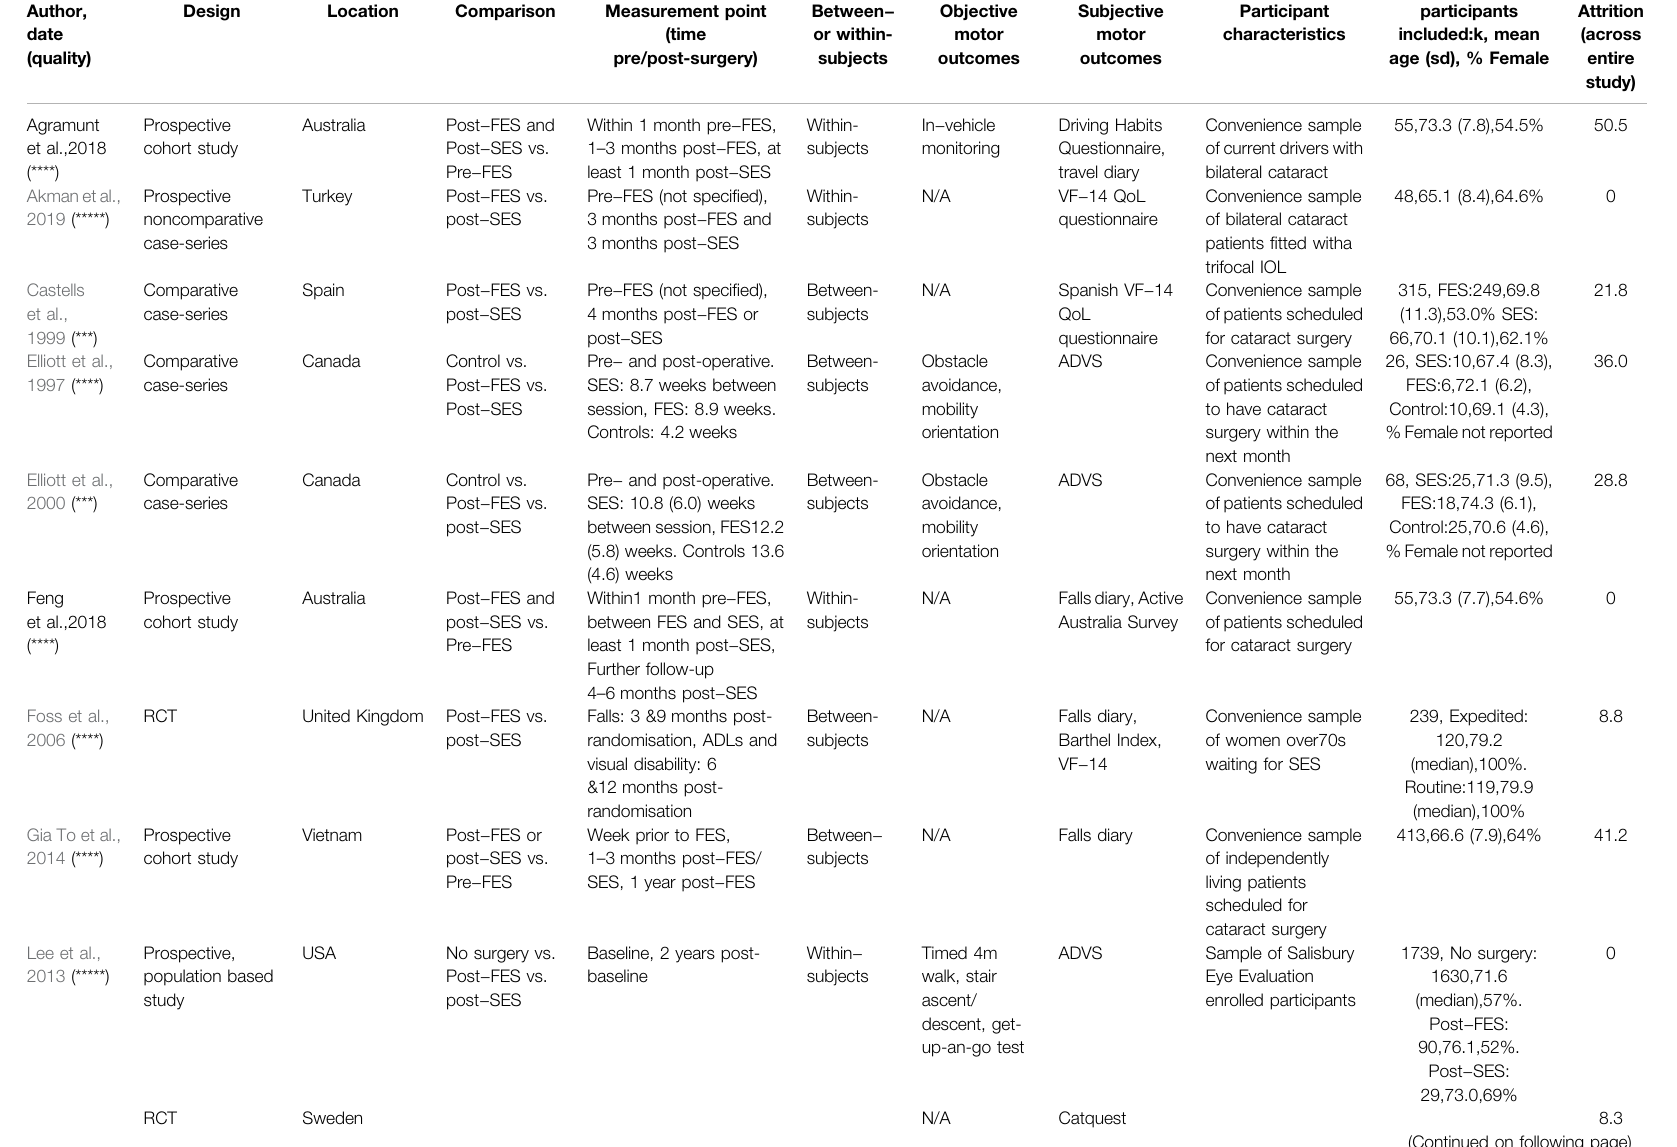
TABLE 1 | Study characteristics. * representants quality assessment score out of fi